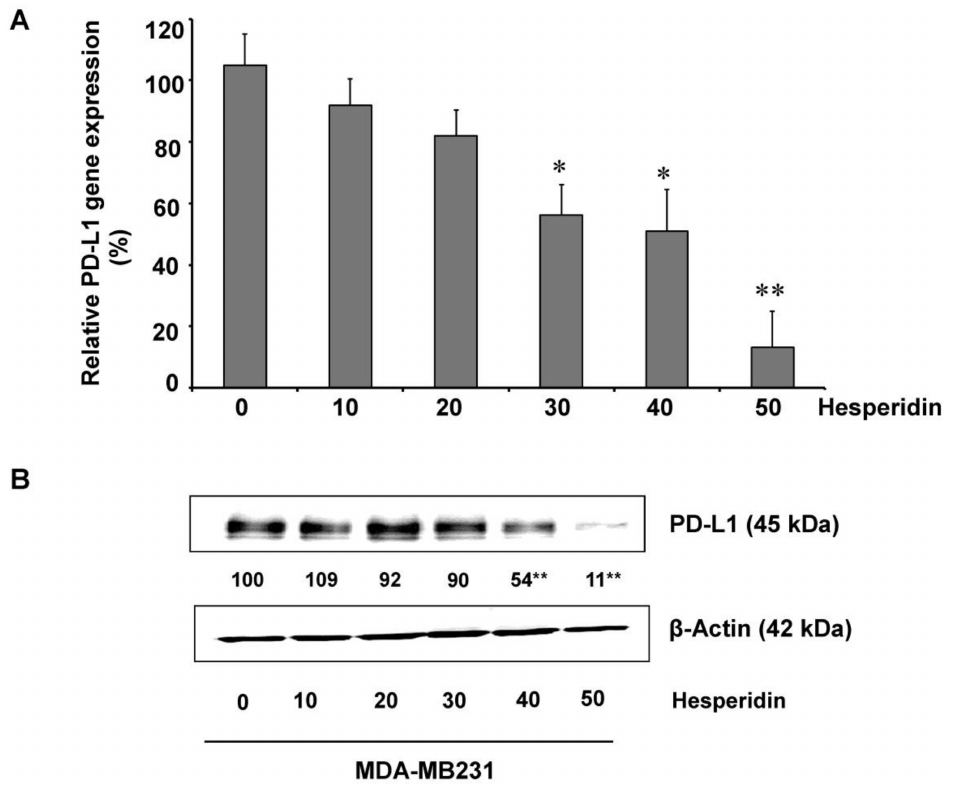
Figure 3. Inhibition of PD-L1 expression by hesperidin in MDA-MB231 cells: ( A ) PD-L1 mRNA expression and ( B ) protein levels of PD-L1 protein. Data indicated as mean ± SD of three independent experiments. Statistical significance * p < 0.05 and ** p <